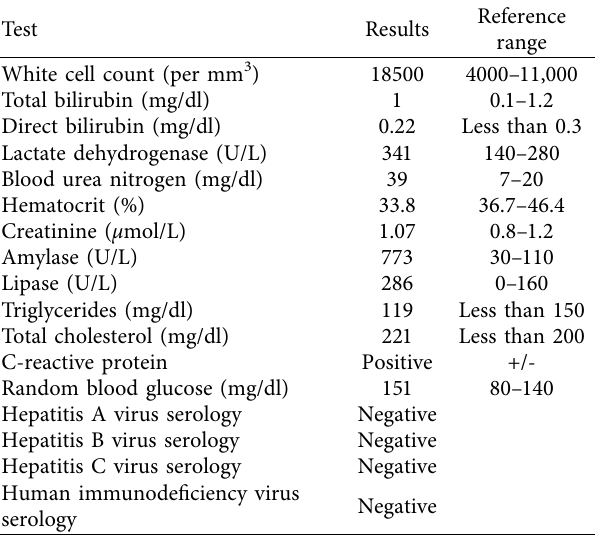
Table 1: Laboratory results on